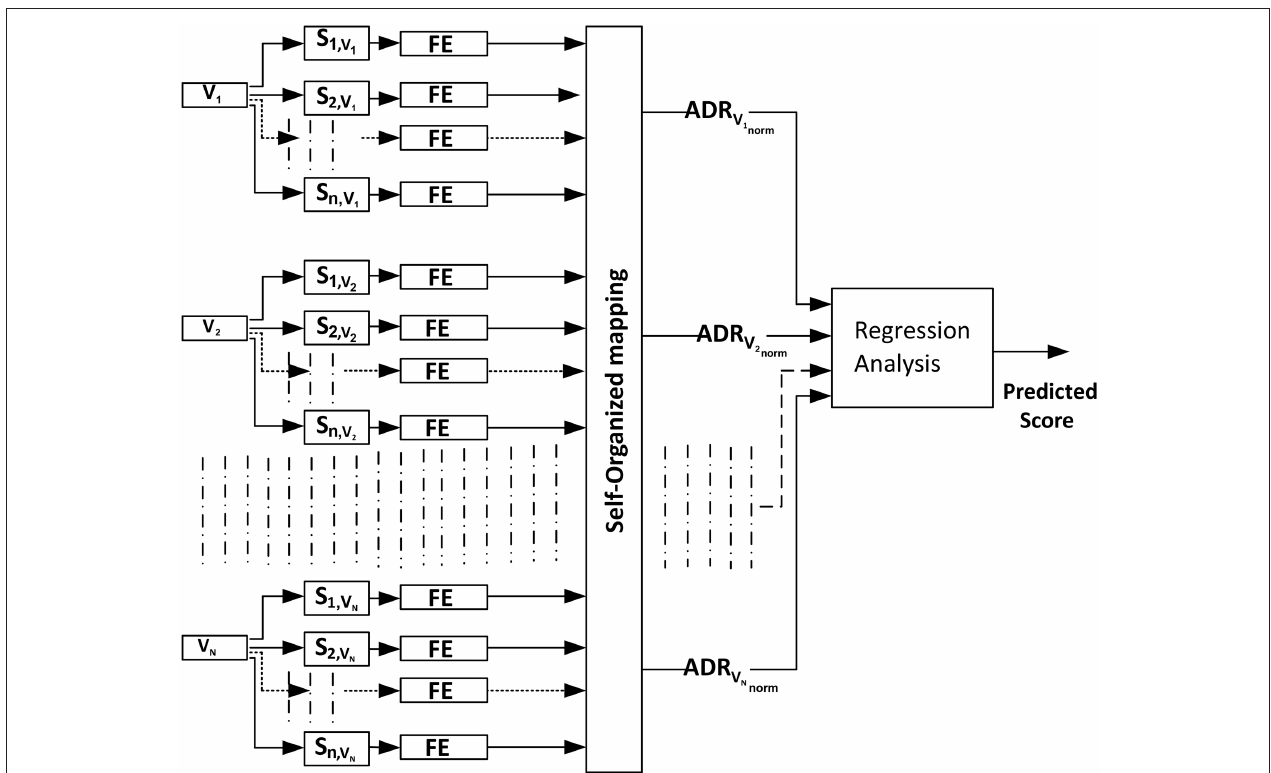
FIGURE 2 | Automatic scoring of an oral presentation process using the Active Data Representation ( ADR V level features from segments of